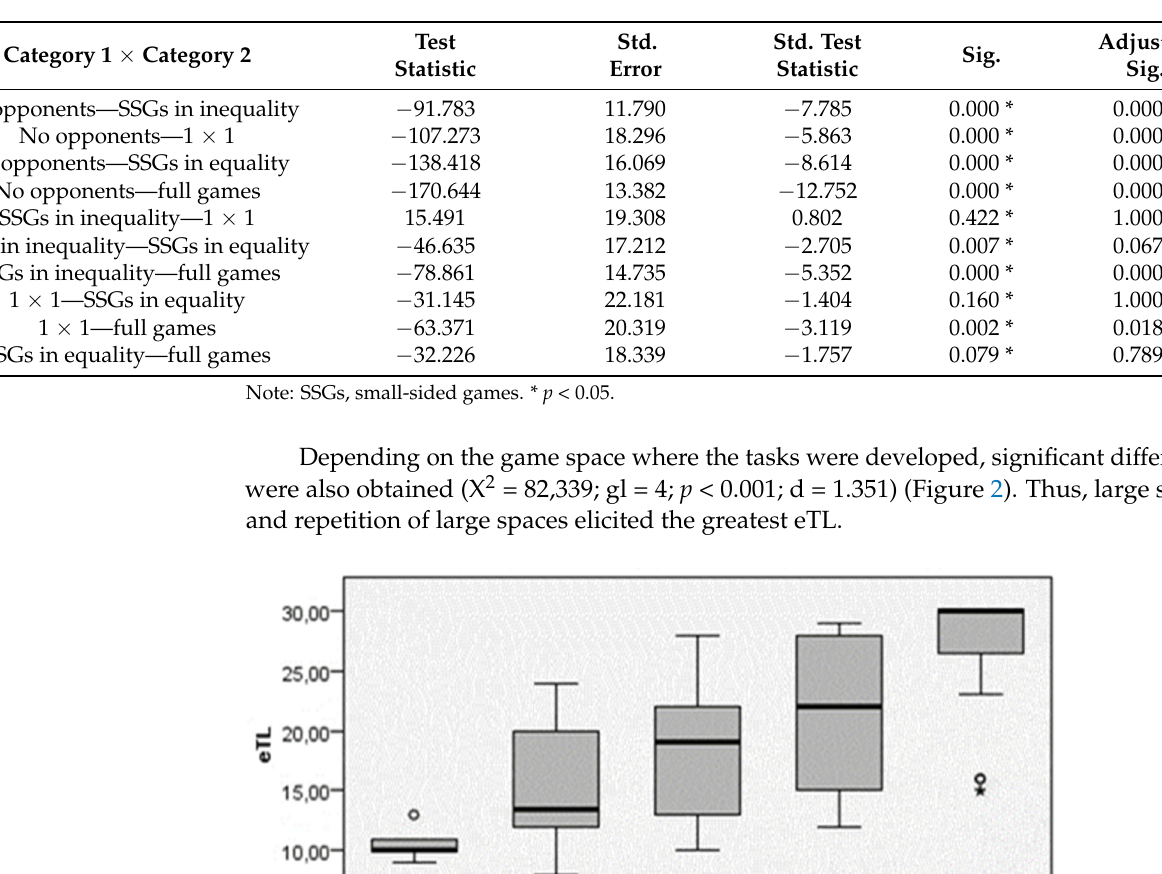
Table 4. Pairwise comparisons (for the eTL) of the game situation categories.